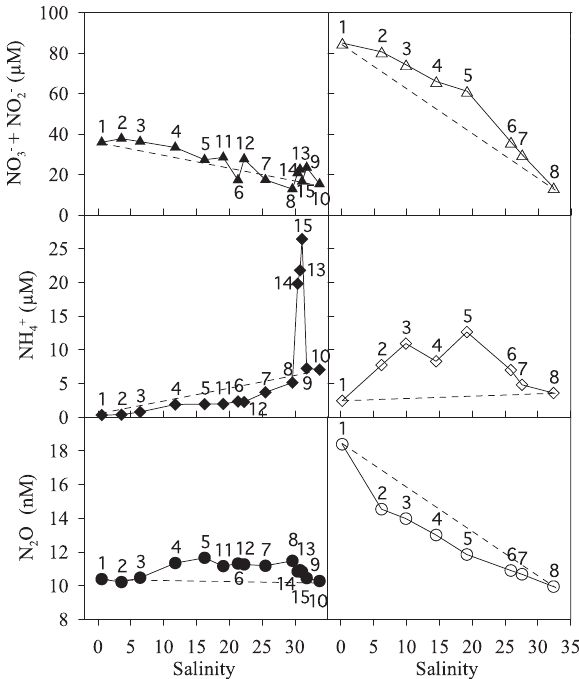
Fig . 3. – Mixing diagrams of nutrients (NO 3– + NO 2– , NH 4+ ) and nitrous oxide (N O) in (A) May and (B) November 2006. Numbers 2 correspond to sampling sites according to map in Figure